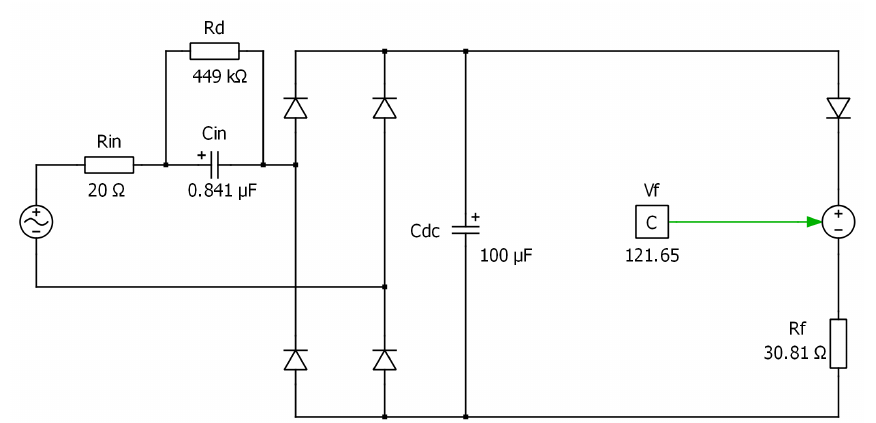
Figure A3. Time domain circuit model of the Type B LED lamp.